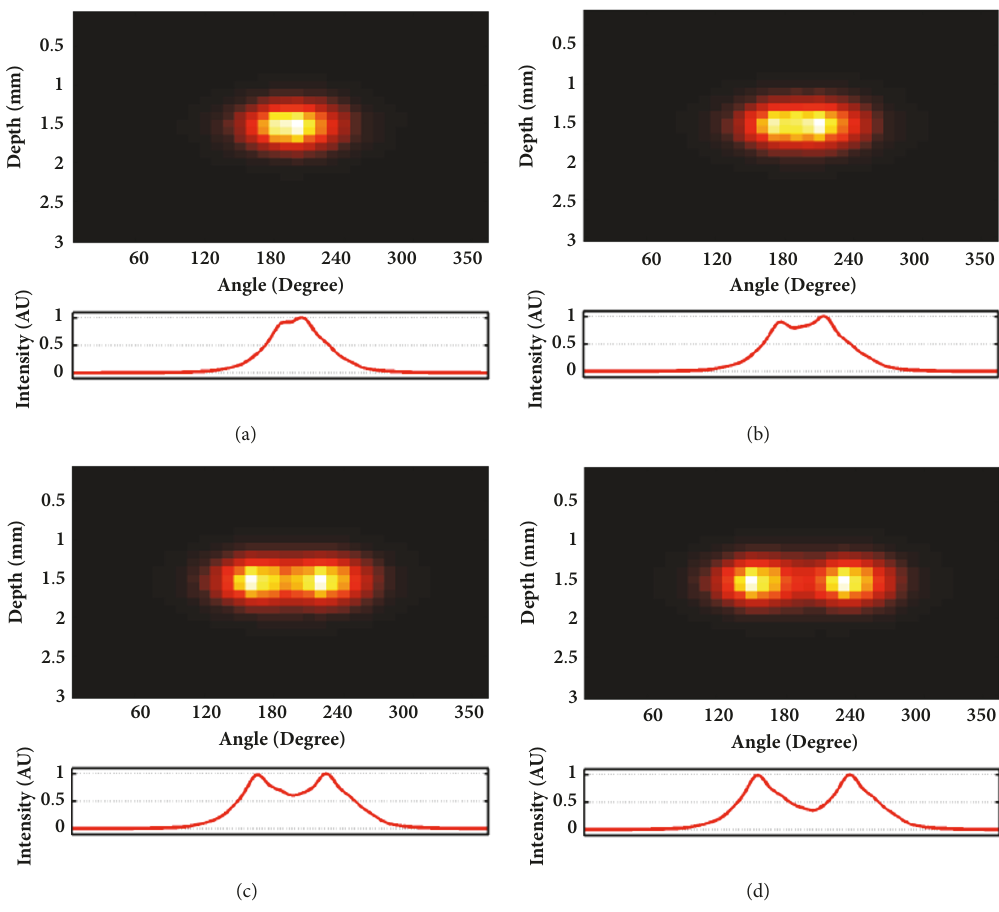
Figure 5: Results from a simulation to find the resolution of our proposed system. Based on this result, when the particles are positioned at the distance of 0.5mm from the fiber tip, the particles are still detectable as two separate particles and the angular distance between them is larger than 50 ∘